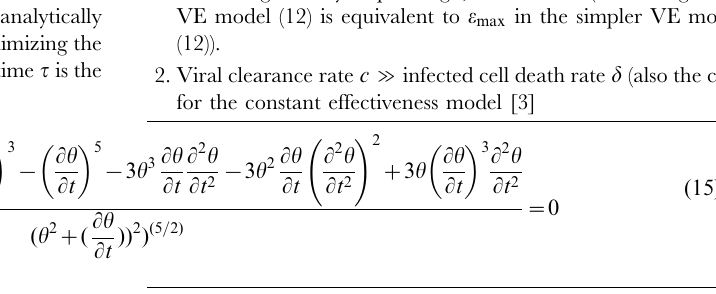
Supporting Fig. S1 shows patient data and model fits from [3] with the transition times marked.